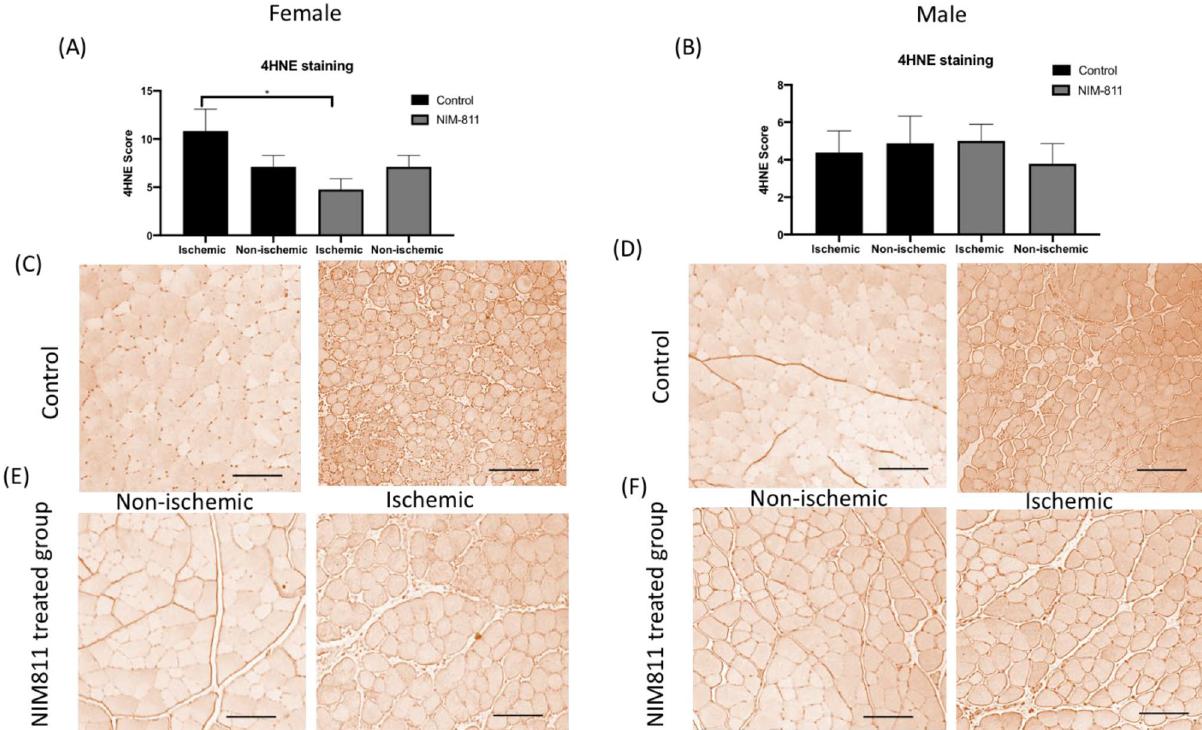
Figure 5. Staining for lipid peroxidation in muscle. ( A , B ) Qualitative difference in lipid peroxidation (4-HNE) staining in TA skeletal muscle from the ischemic and non-ischemic hindlimbs of mice. Lipid peroxidation decreased significantly in muscle from the ischemic limb of female mice treated with NIM-811. *P < 0.05. ( C – F ) Representative images of TA muscle stanning with lipid peroxidation marker 4-HNE showed dense staining